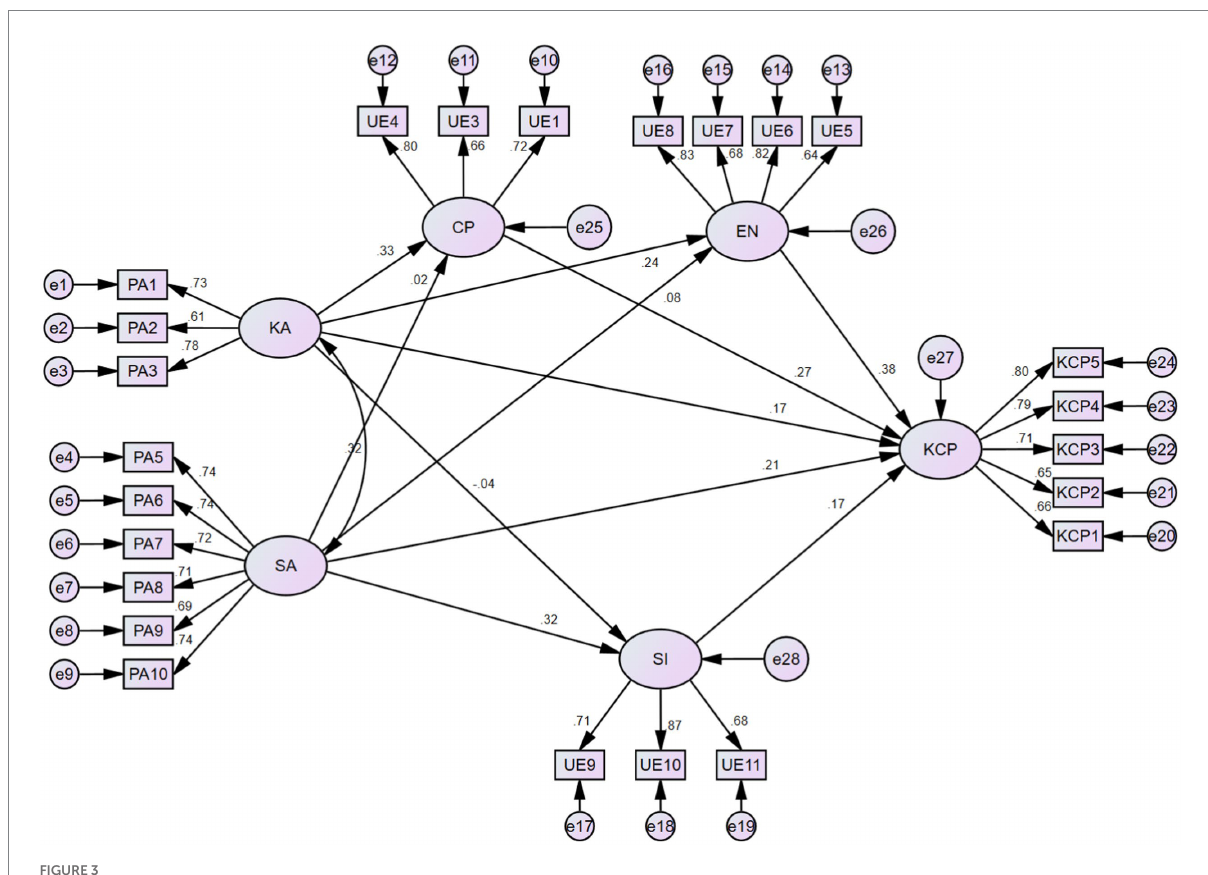
FIGURE 3 Structural equation modeling for the mediating